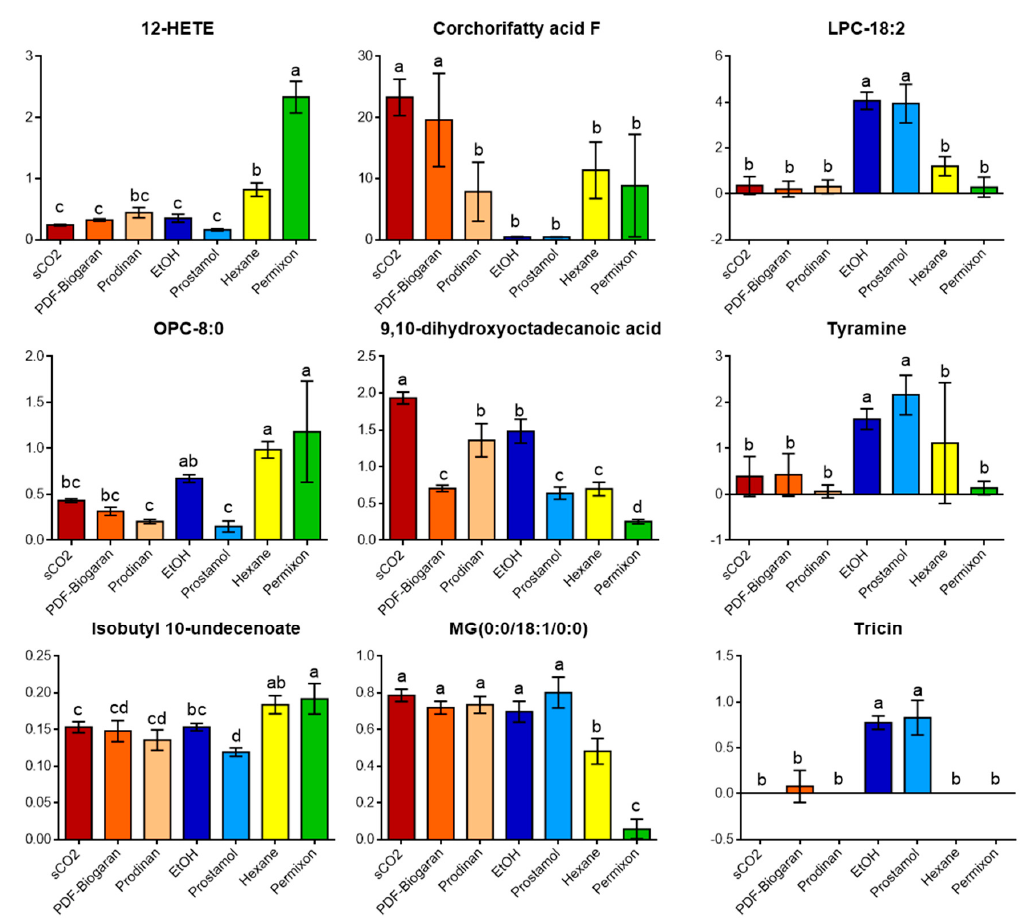
Figure 6. The relative chemical content of annotated biomarkers for each extraction process. The relative mean peak area ( ± SD) detected in laboratory and commercial samples. One-way ANOVA and Tukey’s post-hoc test (DF = 6.24; p ≤ 0.01) were used to assess significant differences among sample